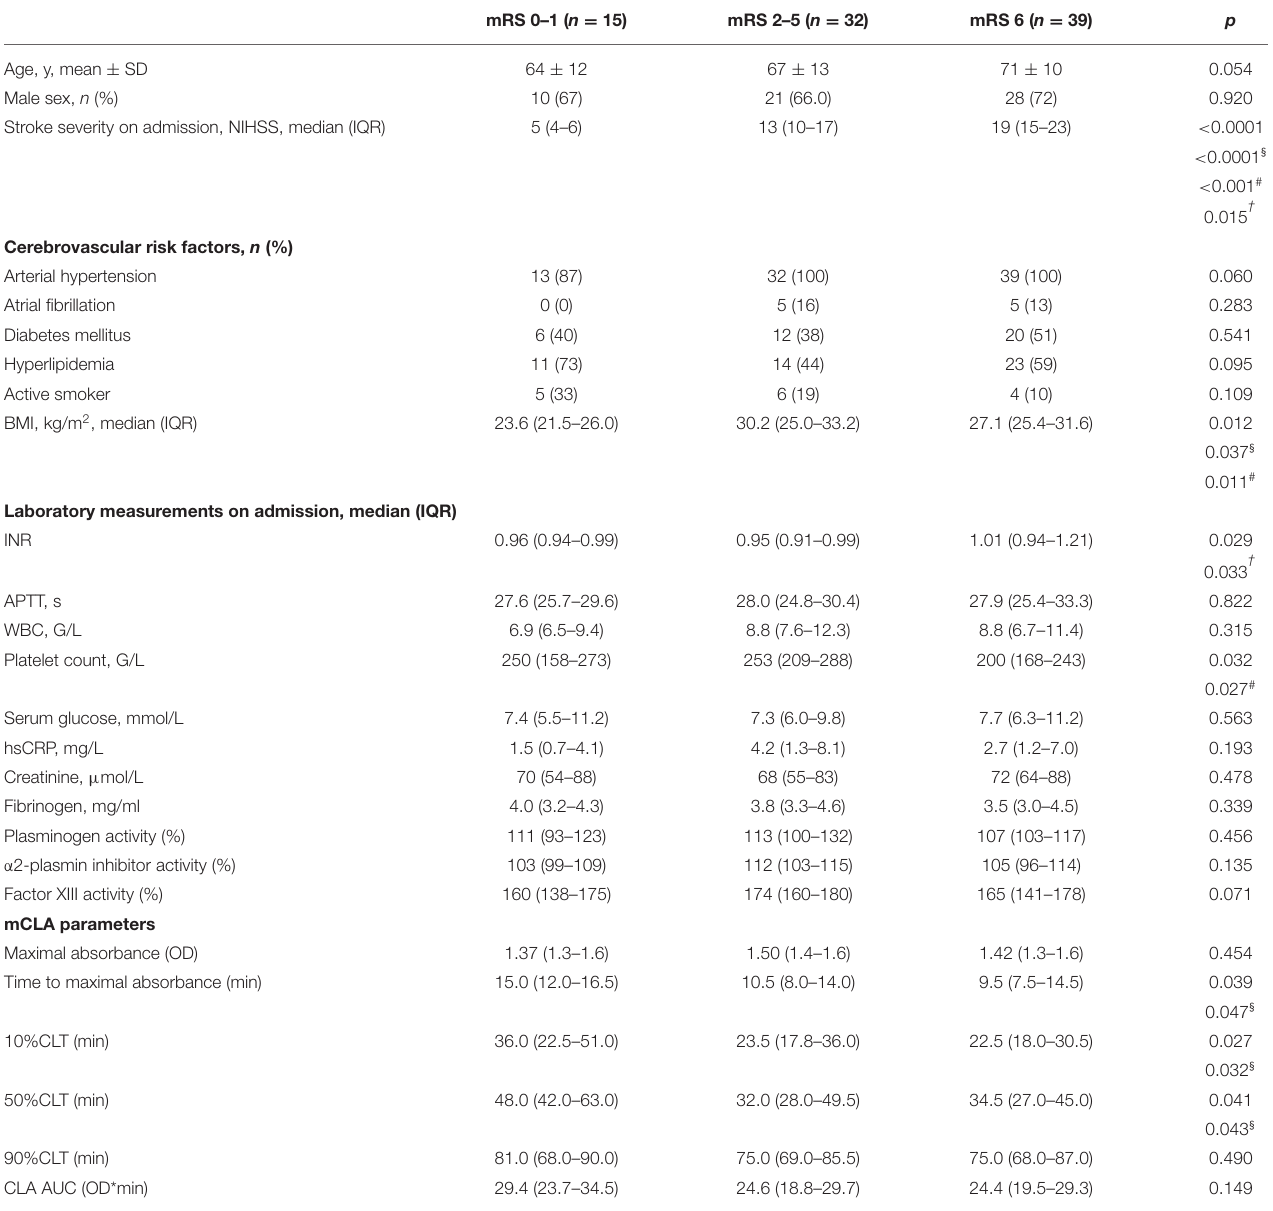
TABLE 4 | Baseline clinical data and modified clot lysis assay (mCLA)* parameters according to long-term functional outcomes at 90 days